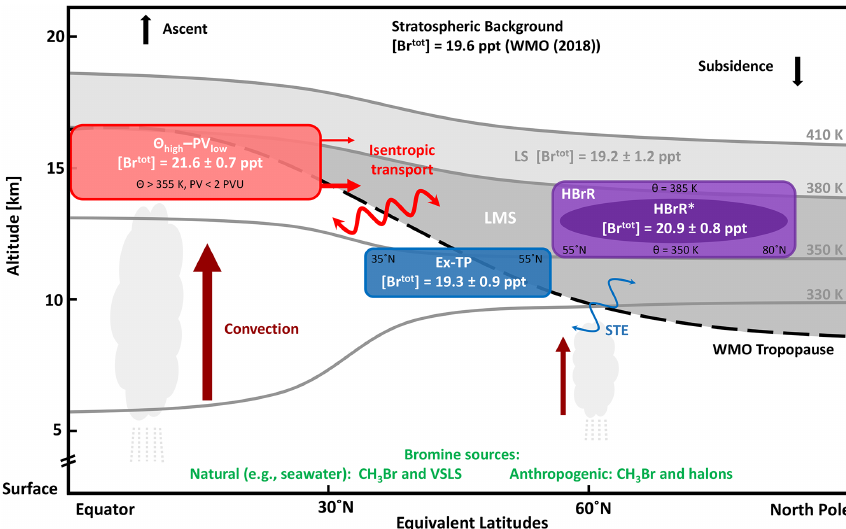
Figure 7. Schematic of bromine transport pathways in the UTLS during the WISE campaign in fall 2017. The dashed black line is the WMO TP. The gray lines are constant potential temperature isentropes. The 380K isentrope marks the upper boundary of the LMS (shaded dark gray region), and the 410K (our measurement upper limit) isentrope marks the upper boundary of the LS (shaded dark + light gray regions). Bromine-rich former tropical UT/TTL air masses at (cid:50) > 355K and PV < 2PVU are labeled (cid:50) high –PV low (shaded red box). The Ex-TP (shaded blue box) is defined here as ± 5K from the local TP between 35 − 55 ◦ N. The transport of bromine from these two regions contributes to the high bromine region (HBrR; shaded light purple box) in the LMS, located between 55 − 80 ◦ N and (cid:50) = 350–385K. The Br tot -inferred measurements larger than the LS mean by more than 1 σ within the HBrR are indicated by HBrR ∗ (shaded dark purple oval). The dark red arrows show regions of strong convection transporting surface air masses (from bromine source regions) to the UT. The two main transport pathways of bromine are from the tropical UT/TTL by isentropic transport (light red arrows) and less by STE across the TP in the extratropics (blue arrow). Br tot VMRs are from the WISE campaign as discussed in the